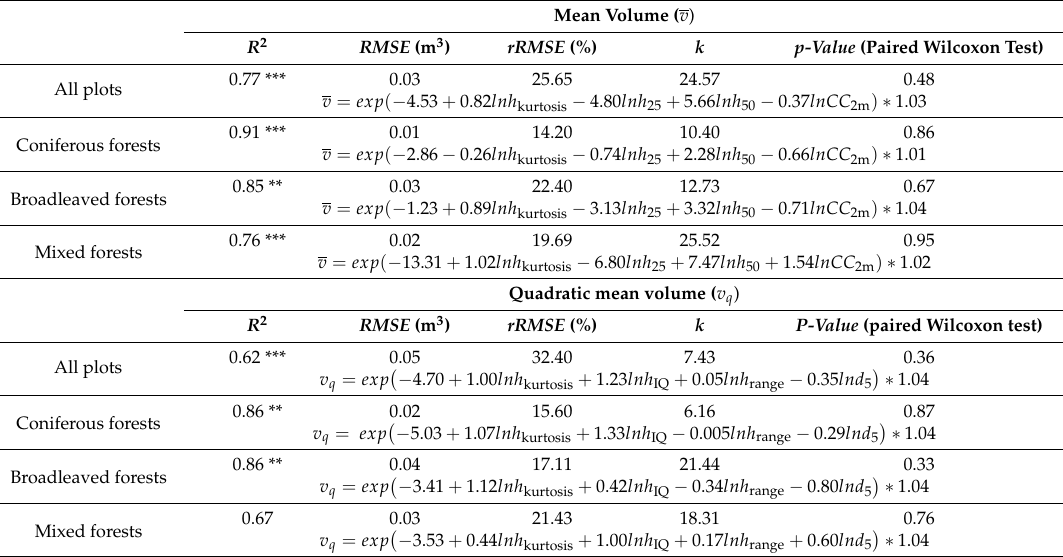
Table 5. Statistics for moment-based parameter recover method (MPRM) models of raw moments v , v q (i.e., mean volume and quadratic mean